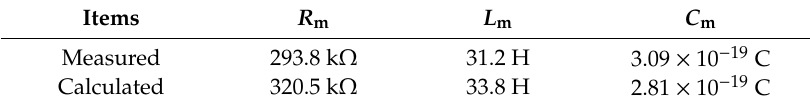
Table 2. Calculated and measured electrical parameters of the Lam é -mode